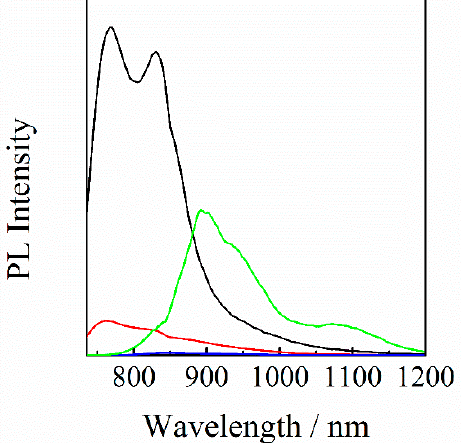
Figure 3. PL spectra of IT-M neat (black line), PBDB-T / IT-M (1 : 1) binary blend (red line), PBDB-T / IT-M / Y6 (1 : 0.8 : 0.2) ternary blend (blue line), and IT-M / Y6 (1 : 1) binary blend (green line) films. All the films were excited at 710 nm, and the PL intensity of all the films was corrected for variation in the absorption at an excitation wavelength of 710 nm. The PL intensity of Y6 in the IT-M/Y6 binary blend was corrected by subtracting the PL intensity due to the direct excitation of Y6 at 710 nm.